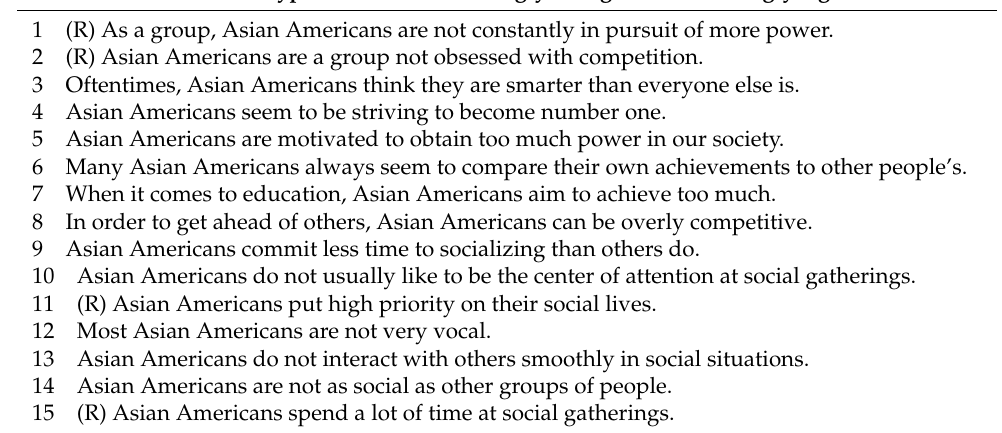
Table 2. The Scale of Anti-Asian American Stereotypes—15-Item Short Version, adopted from Lin, Kwan, Cheung, and Fiske ( ω = 0.86).